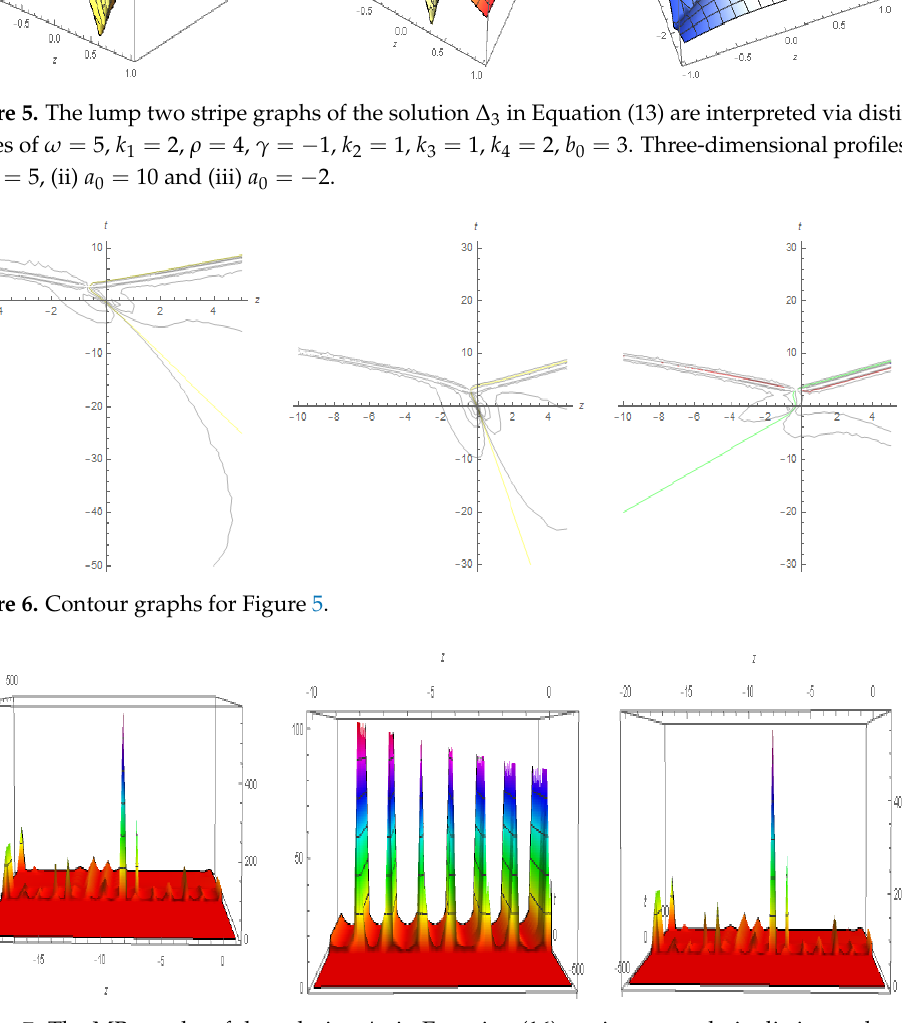
Figure 7. The MB graphs of the solution ∆ 4 in Equation (16) are interpreted via distinct values of ω = 5, p 1 = 2, p 2 = 3, α 1 = 1, α 2 = 2.5, λ 1 = 1, λ 2 = 2, β 2 = 3, ρ = 4, γ 2 = 1. Three-dimensional profiles at (i) a 0 = 5, (ii) a 0 = 10 and (iii) a 0 = −